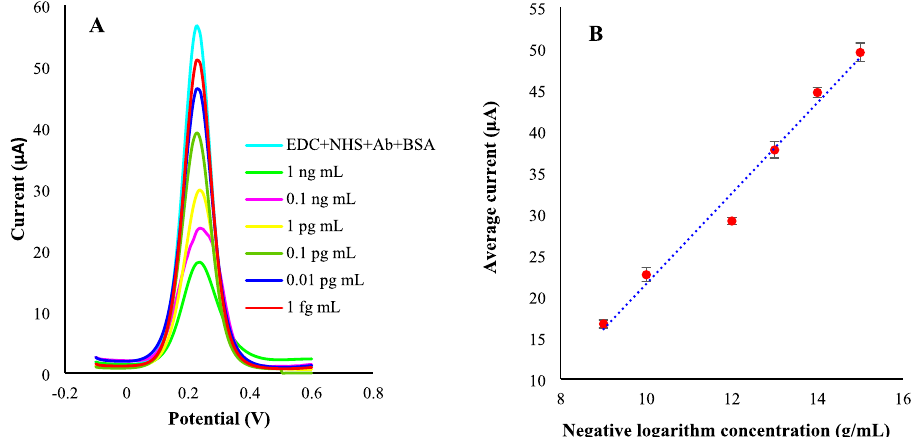
Figure 5. The concentration-electrochemical signals correlation using the proposed immunosensor. ( A ) the current–potential signals and ( B ) the obtained signals for different concentrations of the HER-2 protein (n = 2). The electrochemical measurements were obtained in a PBS buffer (pH = 7.4) of 5 mM K 4 [Fe(CN) 6 ] and 0.1 M KCl. All the DPV measurements were obtained in tha potential range of -0.1–0.6 V with pulse amplitude of 5 mV with interval time of 0.5 s.